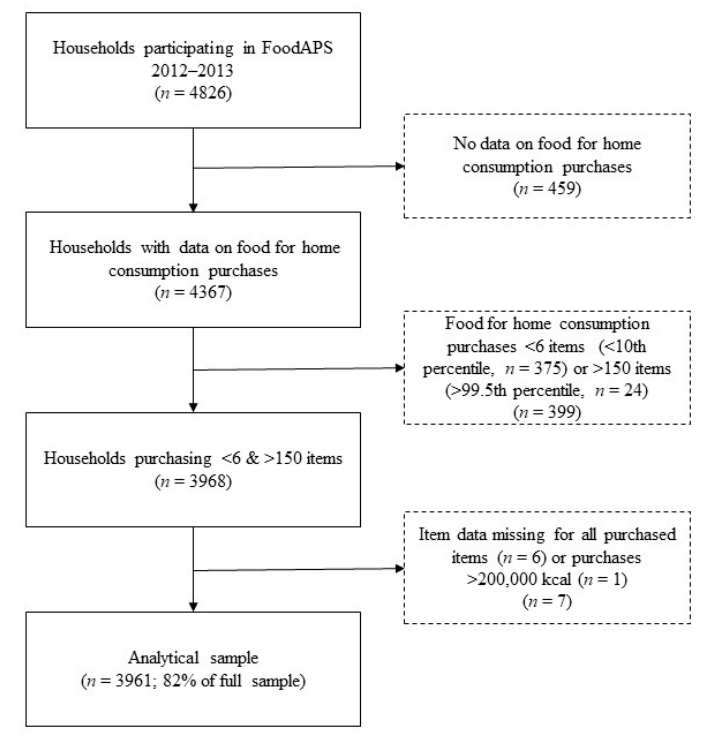
Figure 2. Flowchart of the creation of the analytical sample of households participating in the National Household Food Acquisition and Purchase Survey 2012–2013. Reproduced with permission from Juul et al., 2019